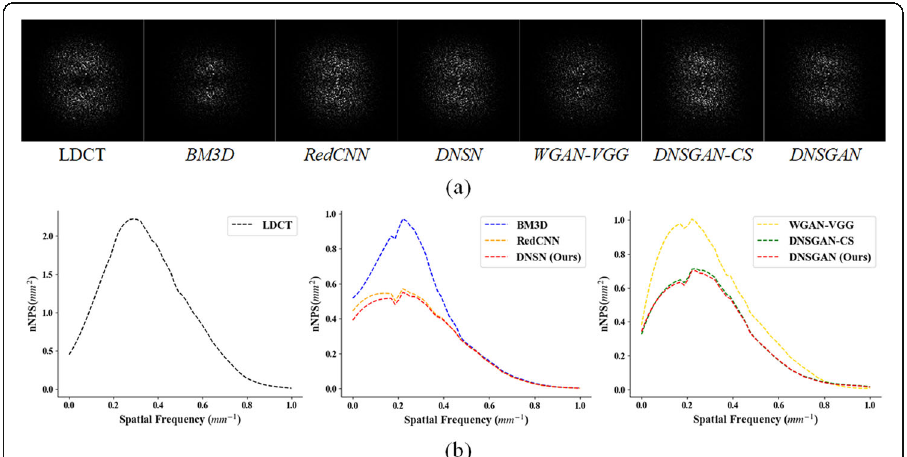
Fig. 6 The 2D ( a ) and radial 1D ( b ) normalized NPS results from all the methods. NPS is calculated with a 120 × 120 pixel ROI and ground truth subtraction is used as the background removal method. Our methods, i.e., PNSR-oriented DNSN and visual perception-oriented DNSGAN achieved noticeable improvements on noise